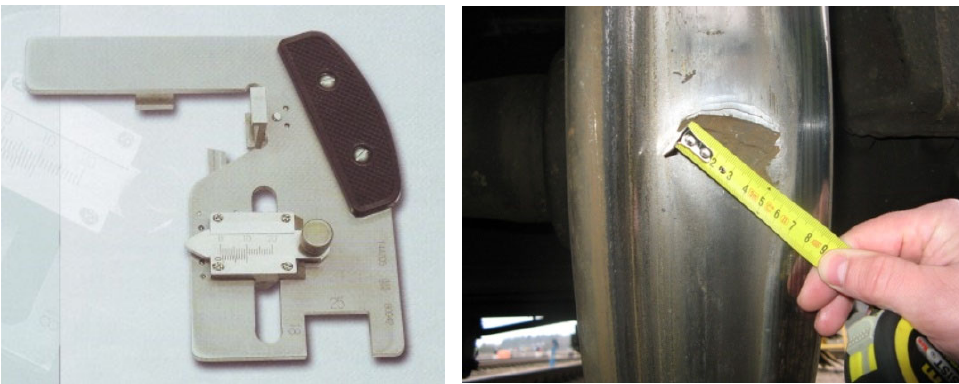
Figure 1. Wheel measurement template and measurement with a ruler. The main damages of the rail wheels are the wear of the rolling surface, thinning of the flange, flats, cracks, and metal folds of the surface. The main types (shapes) of wheel-rolling surface damages are shown in Figure 2.